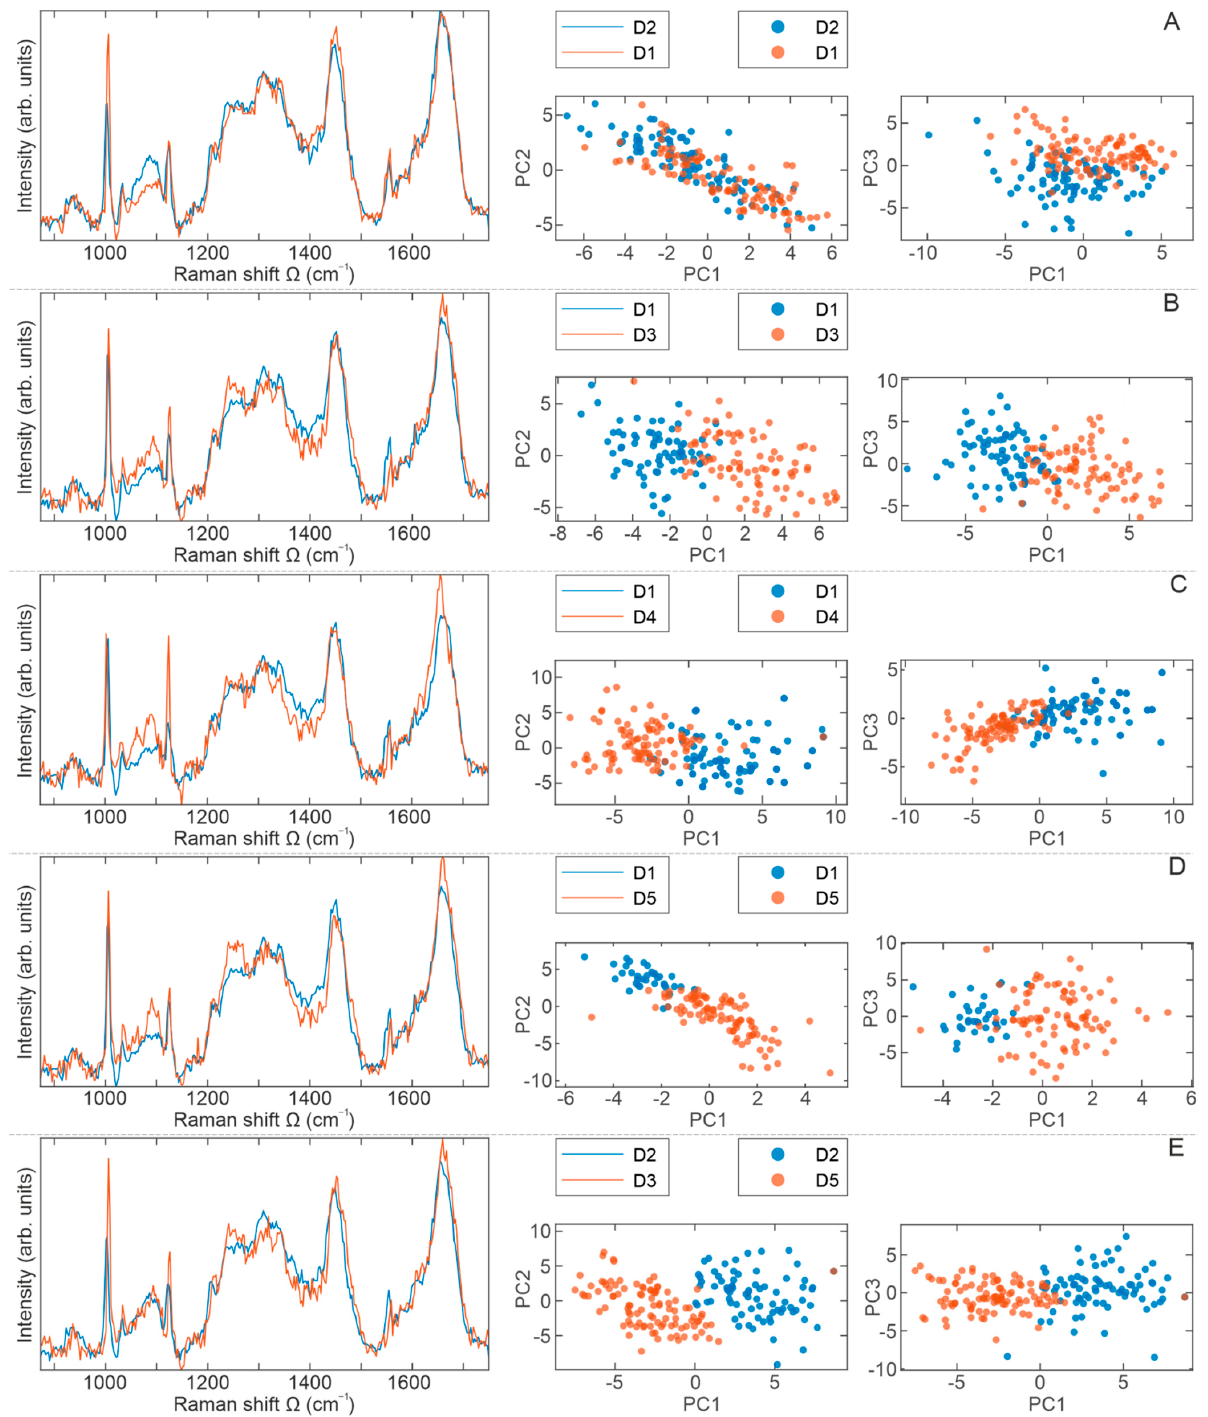
Figure 6. Comparative representation of BM-MSCs Raman spectra presented in pairs. BM-MSCs were seeded on rounded CaF2 slides (Raman grade quality) and cultivated under standard conditions during 24 h. Before Raman scattering experiments, cells were washed with saline buffer and fixed with methanol for 10 min at the room temperature. On average, 50 to 100 cells per each cell population were analyzed. A comparative display of the averaged Raman spectra (red and blue lines) per cell populations: ( A ) D1–D2, ( B ) D1–D3, ( C ) D1–D4, ( D ) D1–D5, and ( E ) D2–D3. Principal component analysis (PCA) score plots are represented with red and blue